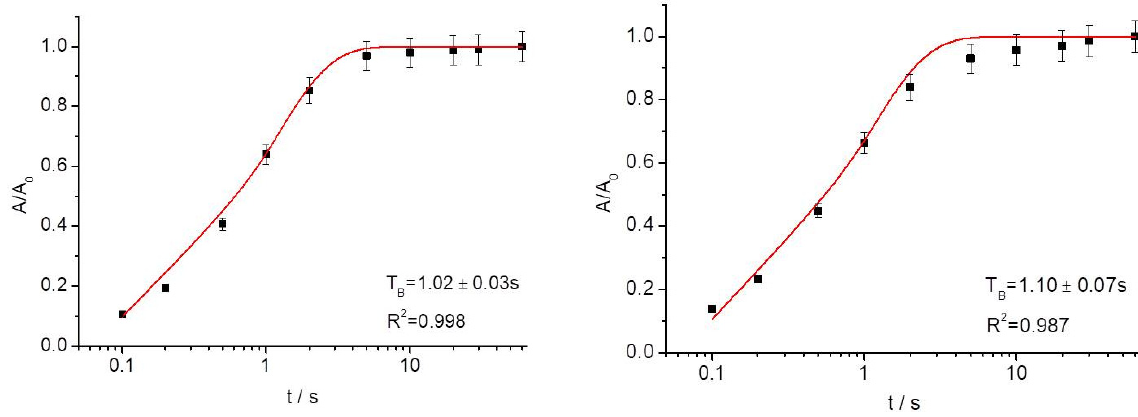
Figure 7. 1 H build-up curves obtained for radical 3 ( left ) and 4 ( right ) at nominal 115 K in the presence ( µ W ON ). The data were fitted to a monoexponential presence (µW ON ). The data were fitted to a monoexponential function.